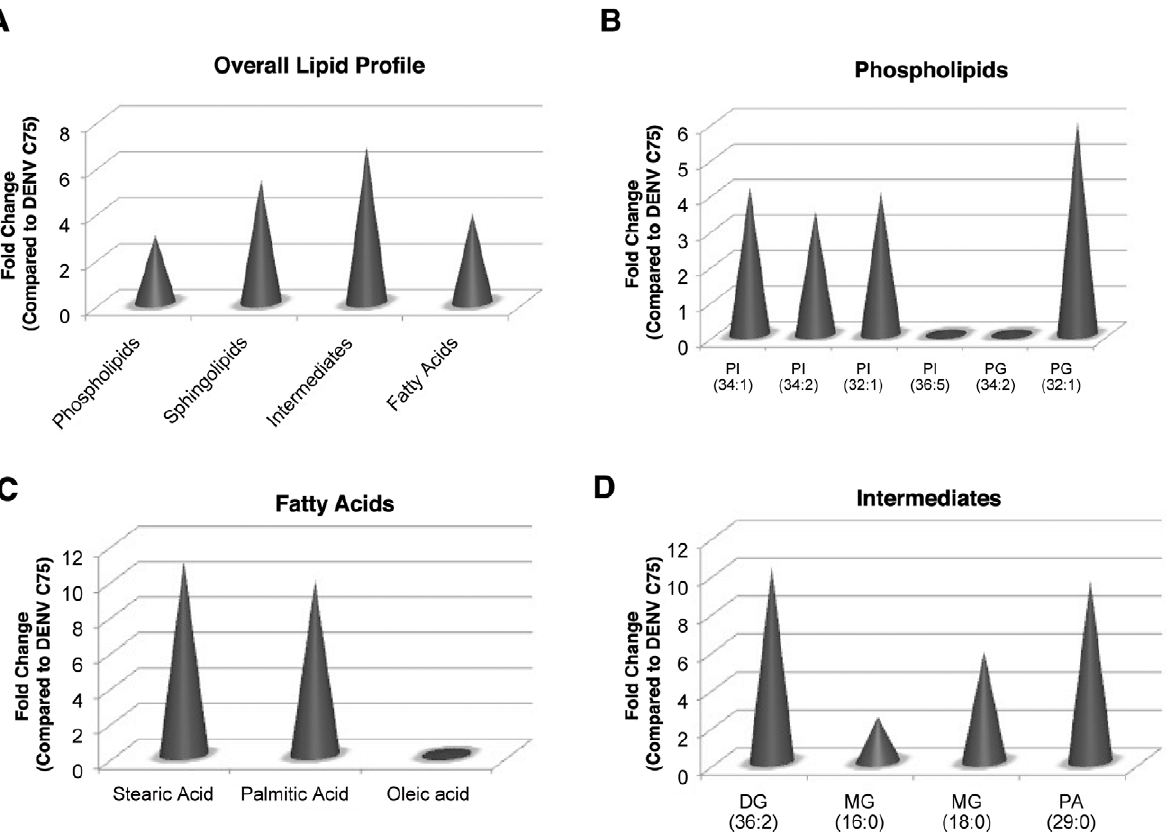
Figure 7. The Lipid repertoire of DENV infected mosquito cells is unfavorable for replication in the presence of C75. The specific lipid classes differentially regulated by C75 treatment of cells are shown. Panel A represents the fold changes of lipid classes expressed in DENV infected cells (MOI 3) compared to C75 treated DENV infected cells. Panels B–D show fold changes for individual molecular species within each lipid class that are regulated. PI, phosphatidylinositol; PG, phosphatidylglycerol; MG, monoacylglycerol; DG, diacylglycerol; PA, phosphatidic acid. See supplementary table S3 for a complete list of lipid features detected in this analysis and supplementary figure 2 for a heat map representation of the data. Three replicates were included in the lipidomic analyses.